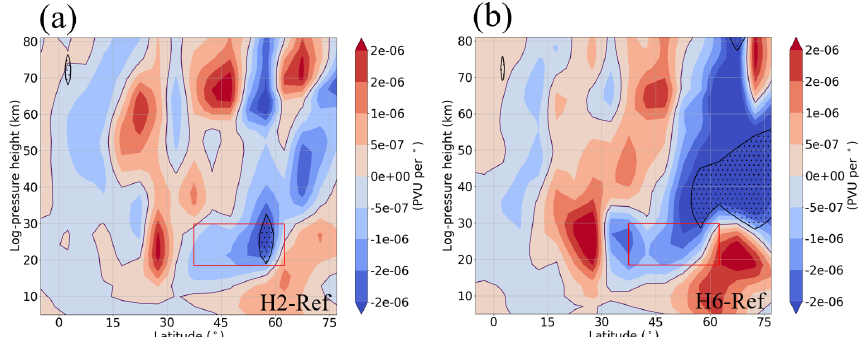
Figure 9. Zonal-mean q y differences between the H2 (a) and H6 (b) simulations and the Ref simulations, given in potential vorticity units (PVU) per degree. The hashed regions denote regions of negative q y of the H2 and H6 simulations. The positions of the GW hotspots are shown by the red